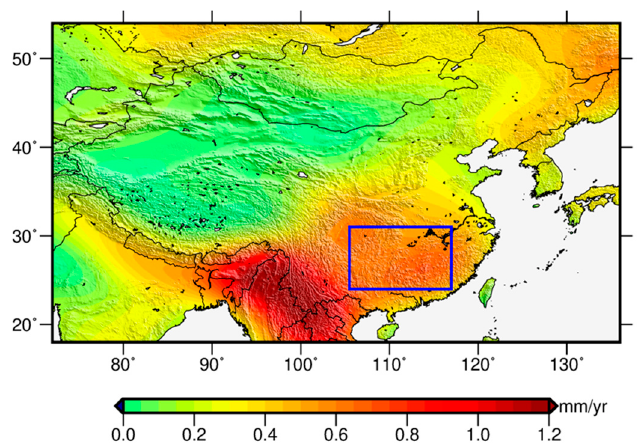
Figure 3. Net primary productivity in 2014, converted to equivalent water heights.